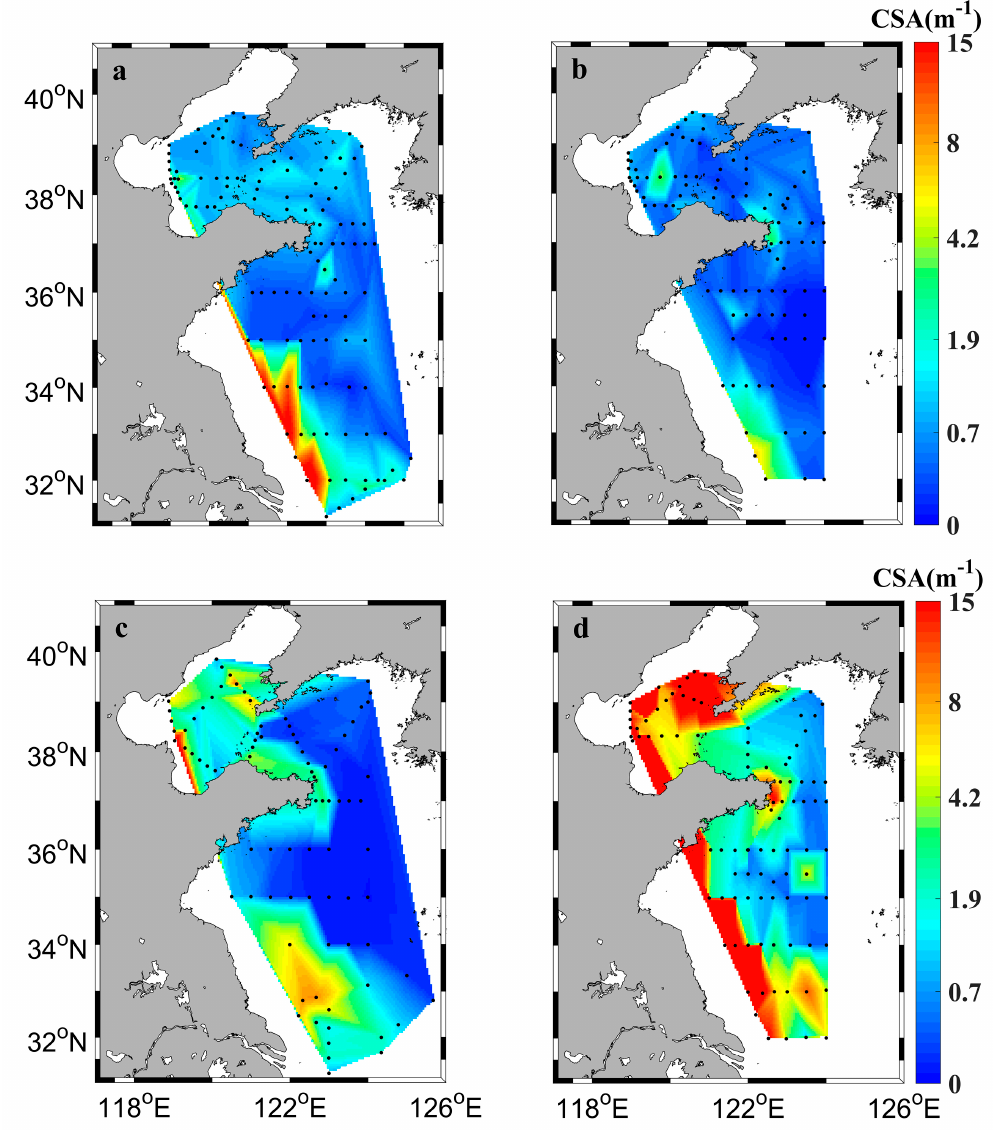
Figure 5. CSA distribution in the middle layer in ( a ) spring, ( b ) summer, ( c ) autumn, and ( d ) winter. The interpolation method was the same as Figure 4.